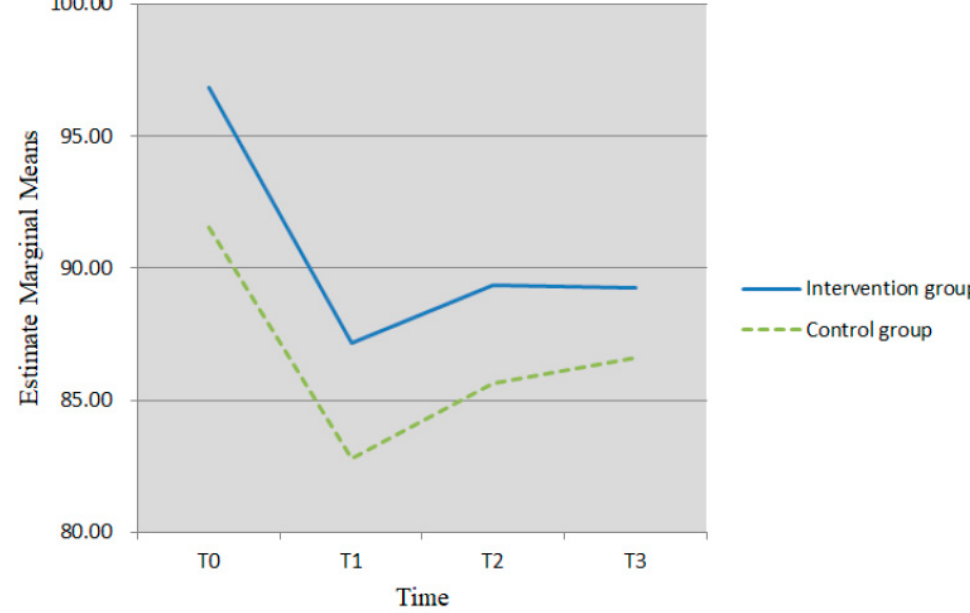
Figure 3. Change of self-care self-efficacy from T0 toT3 in intervention and control groups.